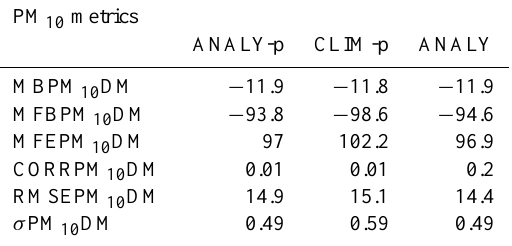
Table 12. Seasonal JJAS statistics obtained with the permutations ANALY-p and CLIM-p. Statistics represent the median values of the permutations. The calculated statistics are mean bias (µg m − 3 ), mean fractional bias (%), mean fractional error (%), correlation co- efficient, root mean square error (µg m − 3 ) and sigma ratio. Statis- tics are computed for the PM 10 daily mean concentrations. PM 10